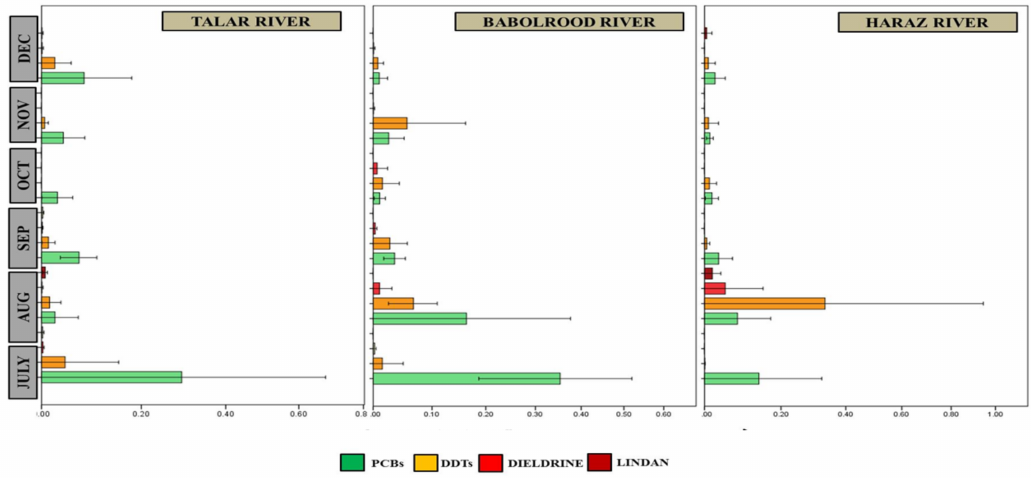
Figure 3. Mean monthly variations of legacy POPs (ng / L) in the Talar, Babolrood and Haraz Rivers at each station.